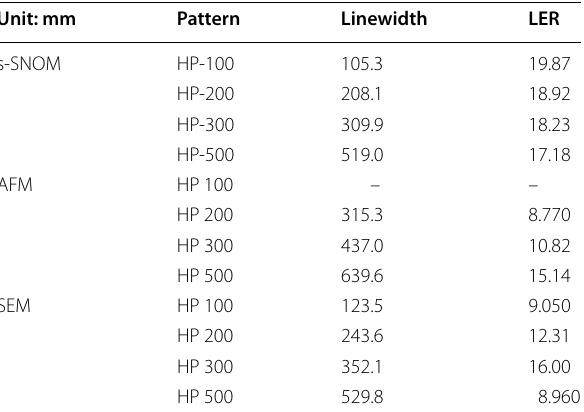
Table 1 Linewidth and LER values from s‑SNOM, AFM, and SEM. HP 100 nm image from AFM was excluded from the evaluation because it was not fully